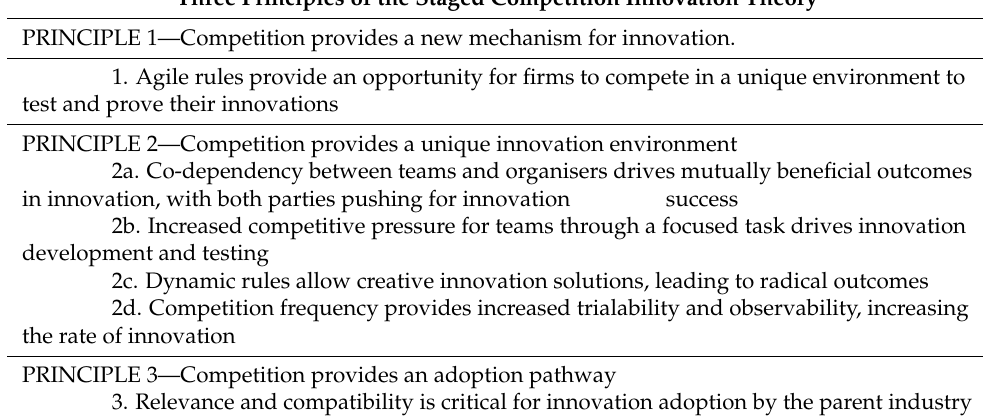
Table 2. Principles of the SCI